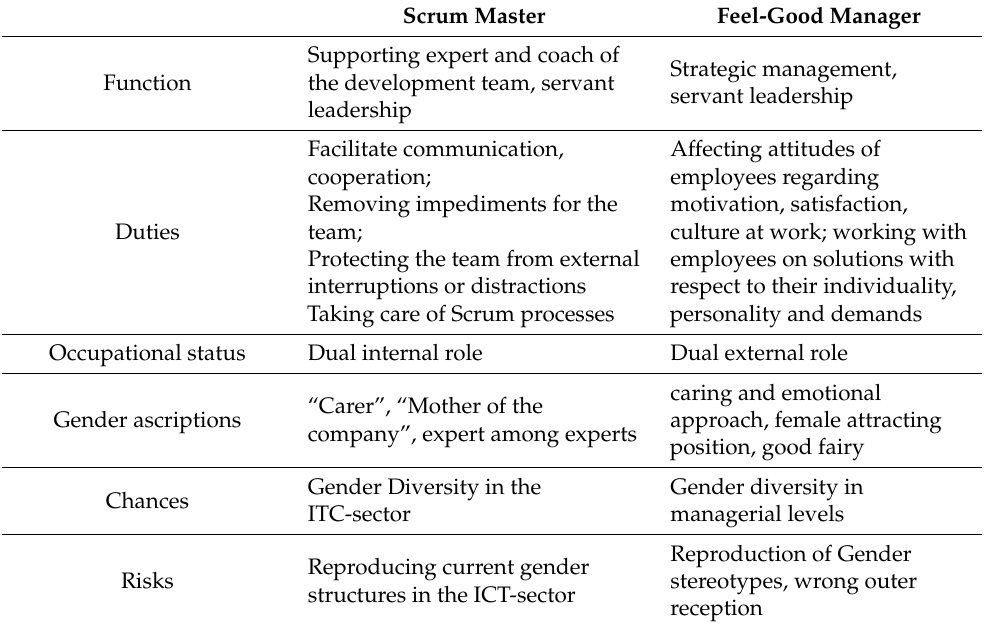
Table 2. Comparison Scrum Master and Feel-good